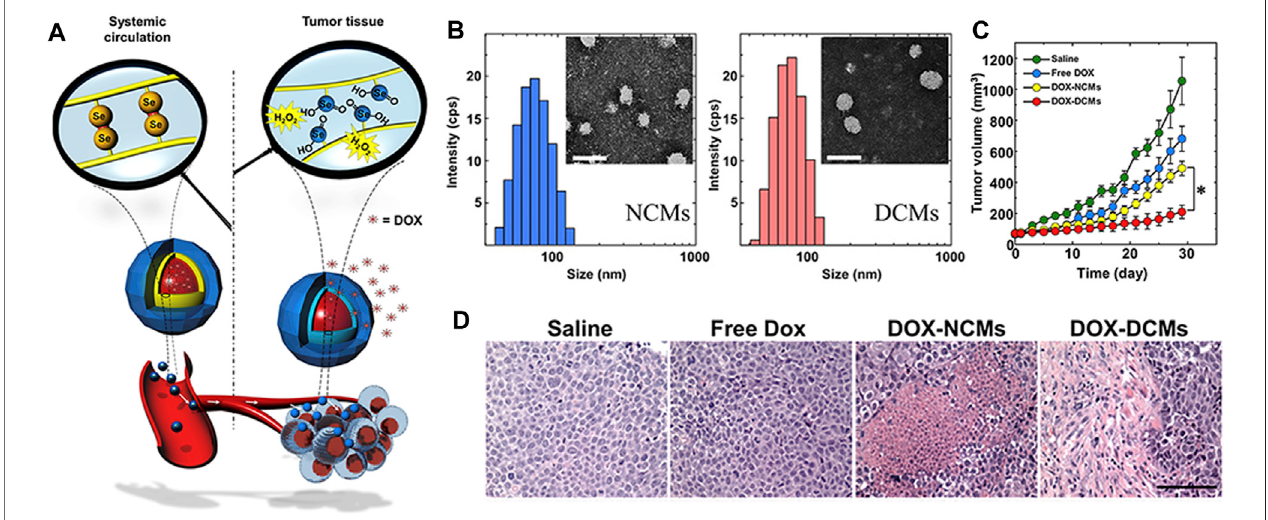
FIGURE8| Characterizationand treatment resultsof insitu DCMs (Deepagan etal.,2016). (A) DCMs maintained stability incirculation and theschematic diagram regarding DCMs triggering drug release by lysis in the tumor tissue. (B) Size distribution ofNCM and DCMs. (C) Tumor growth curve. (D) H &E staining images of tumor